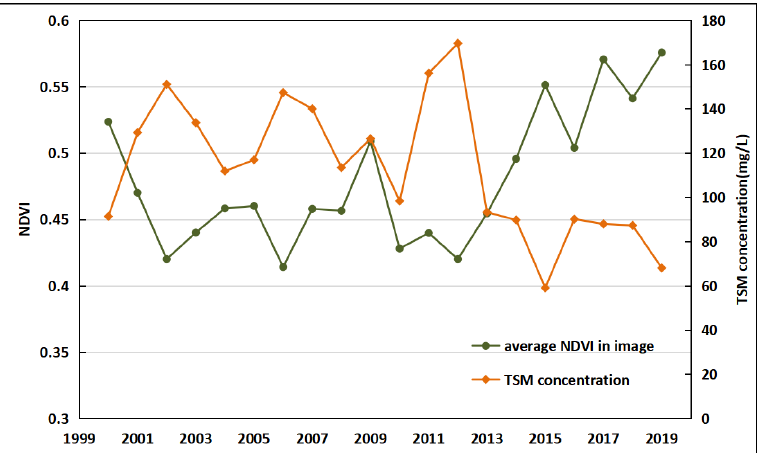
Figure 10. Changes in the average NDVI value for the Landsat image as well as the C TSM at the mouth of the river in the period 2000–2019.